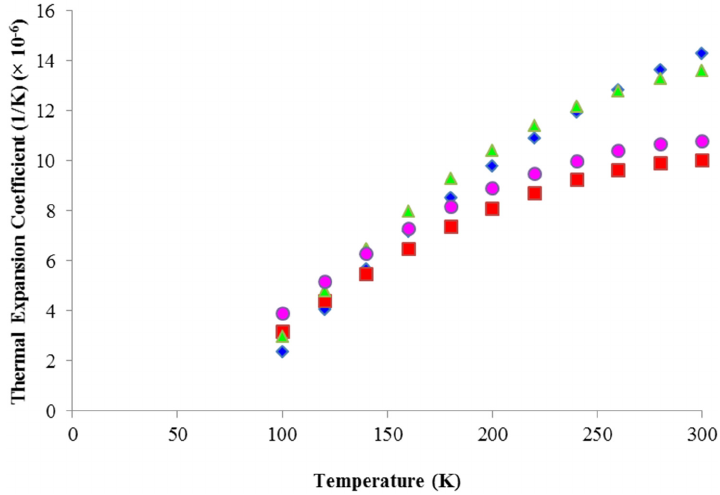
Figure 21. Thermal expansion coefficient as a function of absolute temperature for the uniaxial laser materials YLF along the a (blue) and c (red) axes [29] and LuLF along the a (green) and c (pink) axes [29]. All data are for undoped crystals.